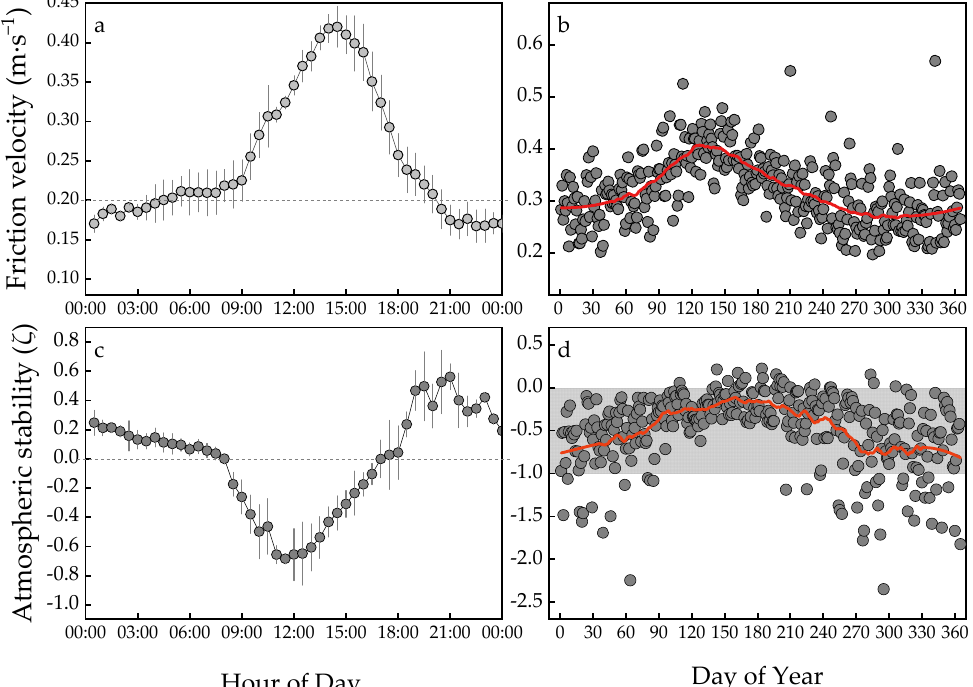
Figure 4. Median daily and annual cycles of frictional velocity ( a , b ), atmospheric stability ( c , d ), and error bars indicate standard errors. Among them, the annual variation diagrams ( b , d ) only represent daytime conditions, where the shaded part shows the range of instability.